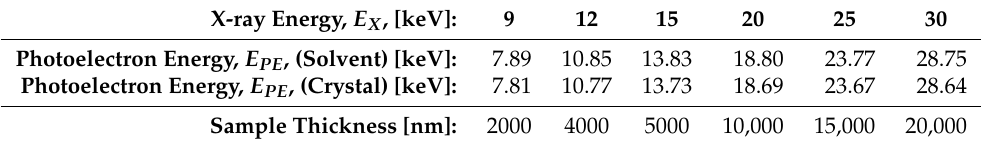
Table 2. CASINO input parameters. The thickness of the sample was adjusted to ensure electron pathways did not exit the sample. The electron energy was slightly different for the solvent and the crystal as differences in chemical composition resulted in a slightly different average ionisation